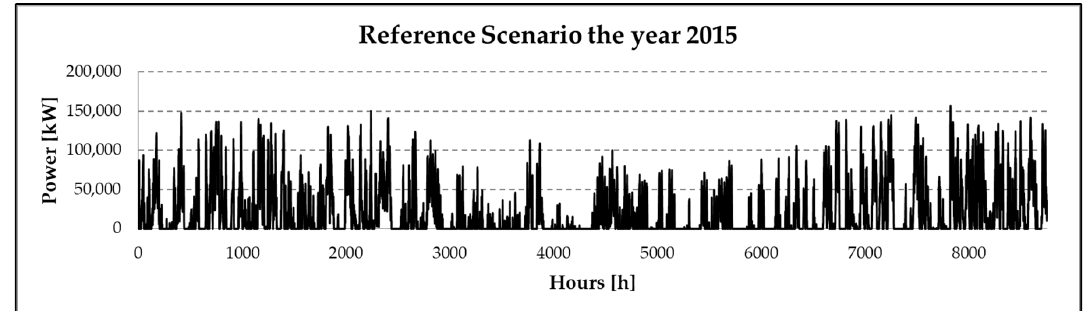
Figure 2. The annual rejected wind power time series for the reference year 2015 [14].